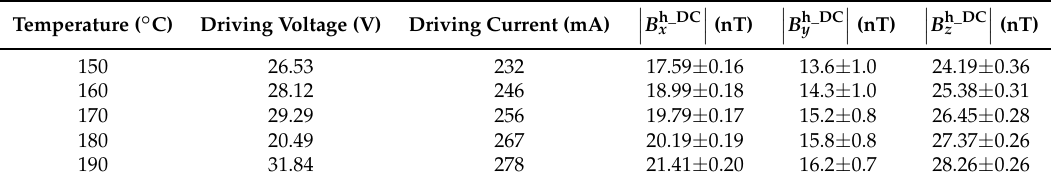
Table 2. The driving voltage, driving current, and the amplitude of three-axis magnetic fields generated (cid:16) B h_DC x , B h_DC y , B h_DC z by the heater. B h_DC =